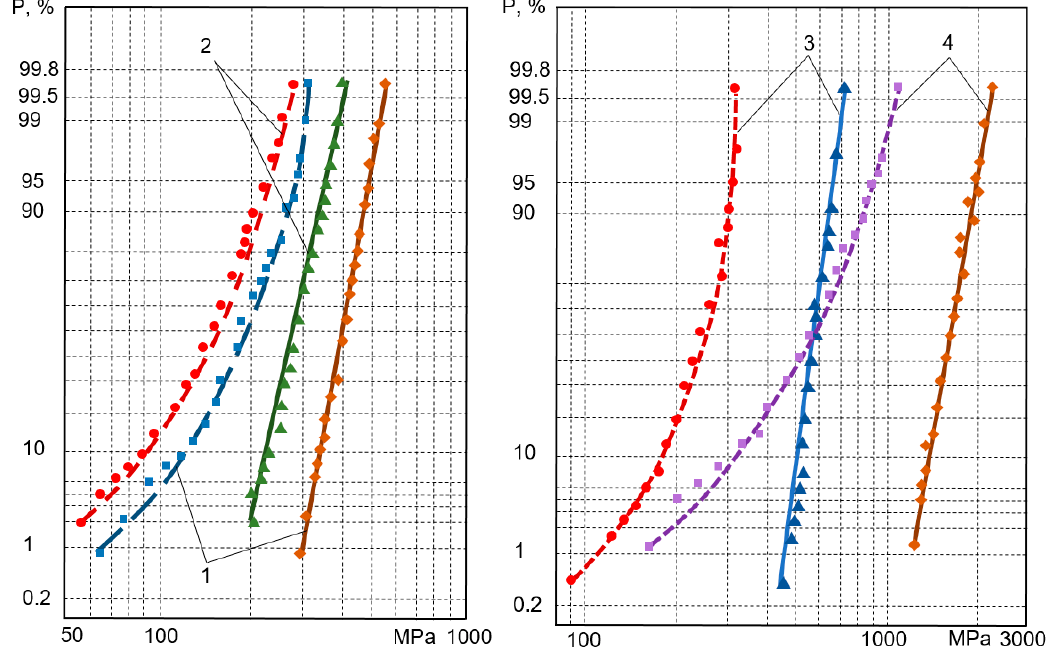
zero. This indicates that sensitivity thresholds N 0 and N k affect agreement of statistical